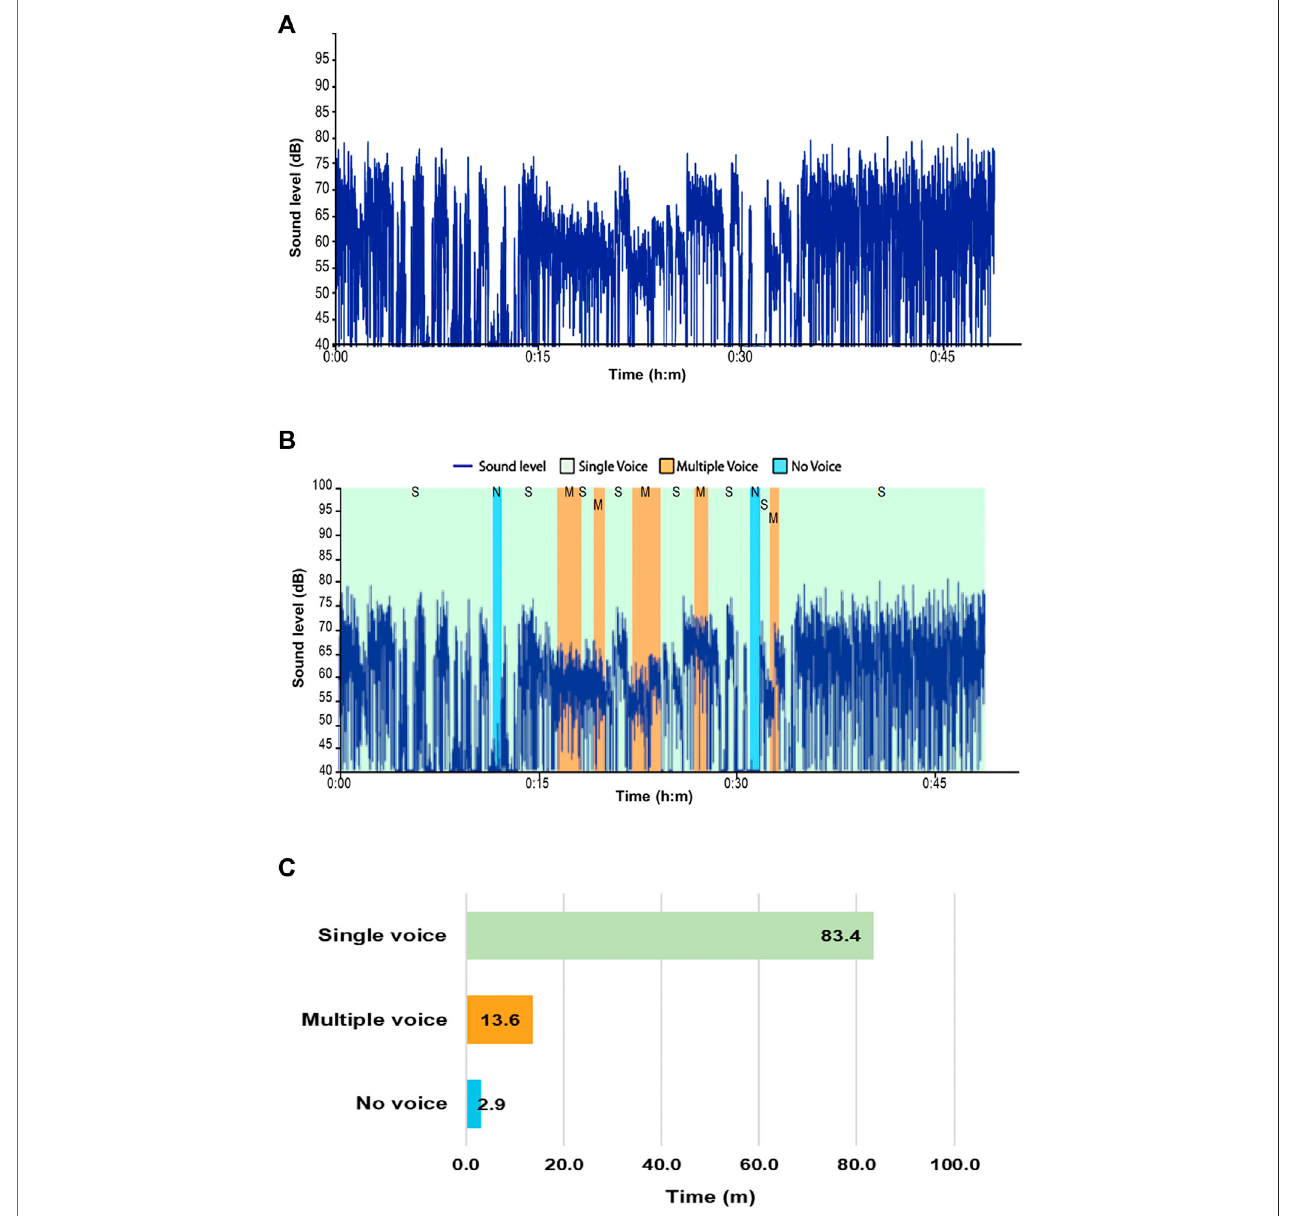
FIGURE2| TheDARTsoundanalysisofasinglelectureshowing (A) thecleanwaveformoftheclassroomsound(decibels)throughoutthelecture(hour:minute), (B) DART predictionofthewaveform,wherecolorsindicatingthreedifferentmodesofsinglevoice(green),multiplevoice(orange),andnovoice(blue)areaddedtothecleanwaveform, (C) the approximate duration of each of the three DART sound categories identi fi ed within a classroom. The fi gures are original outputs produced by the DART